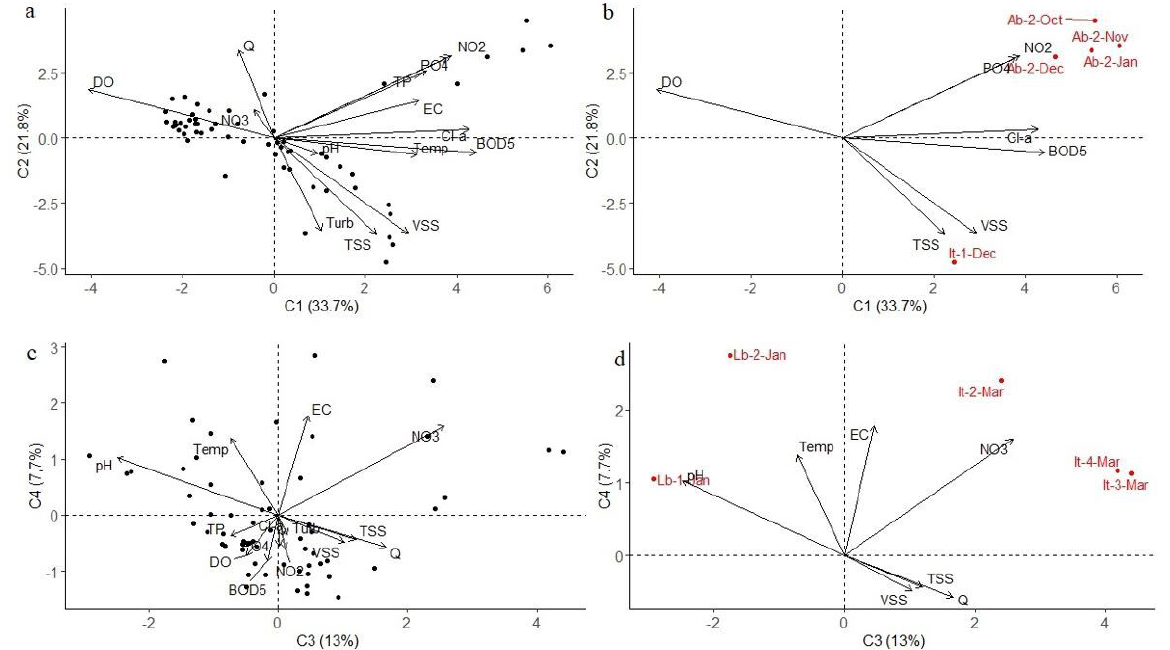
Figure 7. PCA analysis for rainy season data set showing the C1 and C2 (a); variables and sample points of C1 and C2 with higher contribution (b); variables of the C3 and C4 (c); variables and sample points of C3 and C4 with higher contribution